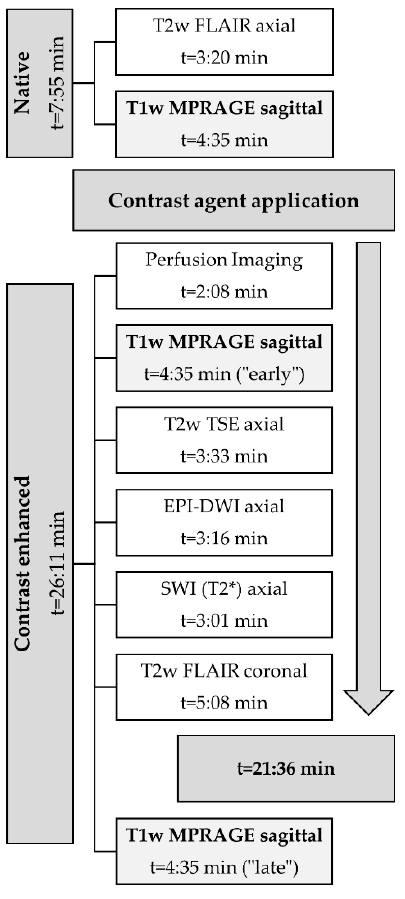
Figure 2. MR protocol.